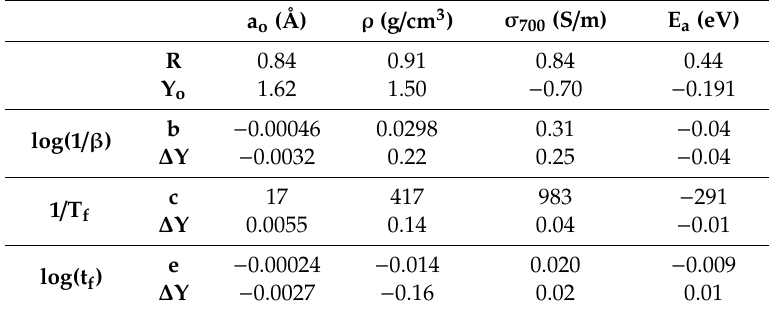
Table 3. Multivariate fitting parameters (Equation (3)), and corresponding contributions of firing factors on lattice parameter, density, electrical conductivity at 700 ◦ C and activation